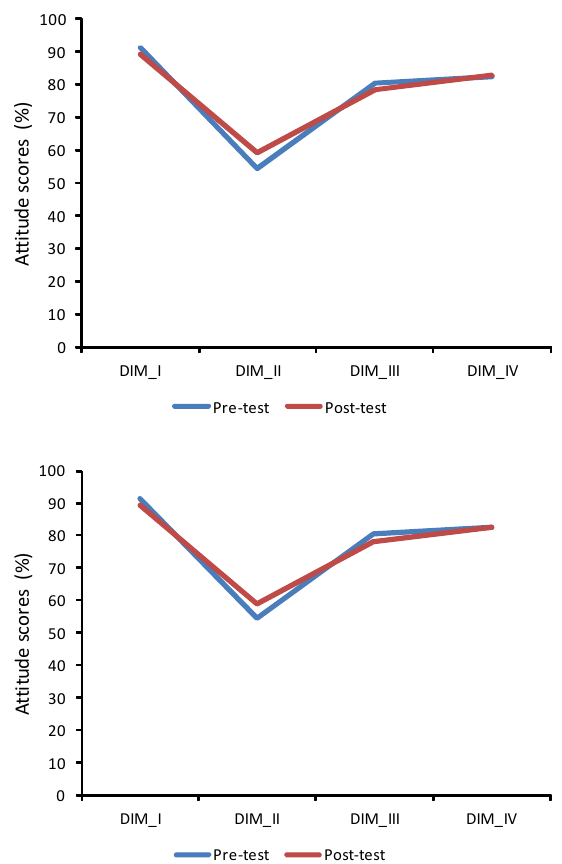
Figure 3. Attitudes scores (%) in each of the four attitude dimen- sions for the IG group, before and after intervention (top), and CGno and CGyes (bottom).